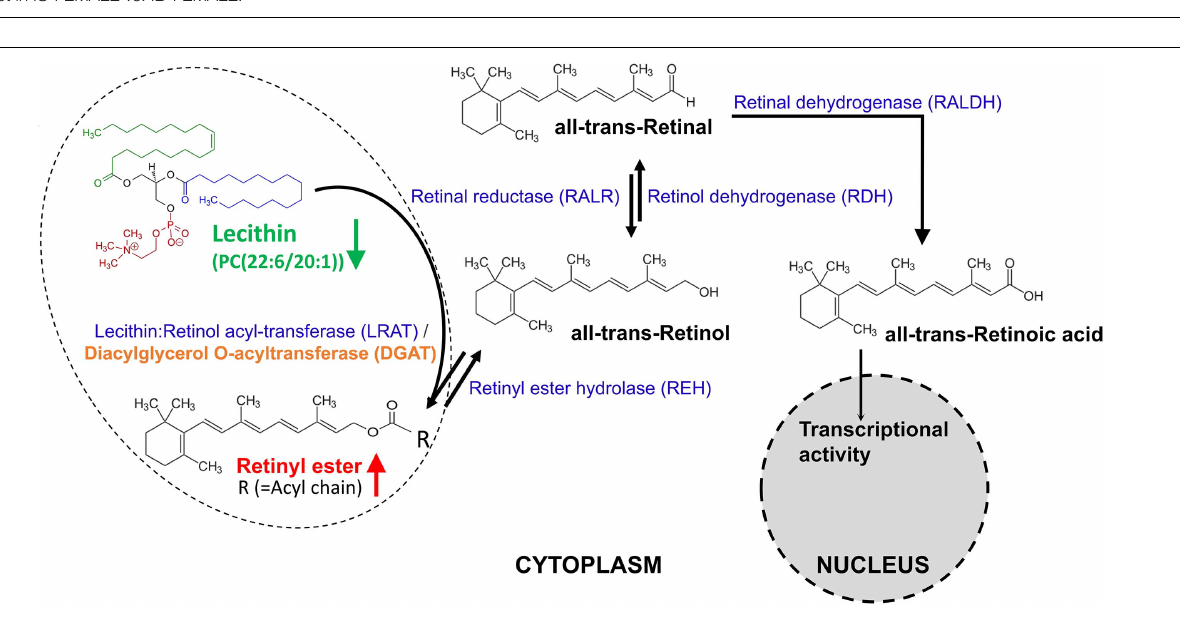
FIGURE 5 | Enrichment analysis of the differential metabolites across comparison groups. (A) : Top 8 enriched metabolite terms of the differentially expressed metabolites of IS-MALE vs. IB-MALE. The bars on x -axis represent the number of metabolites for the chemical classes mentioned on the y -axis. (B) : Enriched metabolite sets of the differentially expressed metabolites of IS-MALE vs. IB-MALE. (C) : Top 11 enriched metabolite terms of the differentially expressed metabolites of IS-FEMALE vs. IB-FEMALE. (D) : Enriched metabolite sets of the differentially expressed metabolites of IS-FEMALE vs. IB-FEMALE. (E) : Enriched metabolite terms of the common differentially expressed metabolites between IS-MALE vs. IB-MALE and IS-FEMALE vs. IB-FEMALE. (F) : Enriched metabolite sets of the differentially expressed metabolites between IS-MALE vs. IB-MALE and IS-FEMALE vs. IB-FEMALE. (G) : Enriched metabolite terms of the differentially expressed metabolites distinct in IS-MALE vs. IB-MALE. (H) : Enriched metabolite sets of the differentially expressed metabolites distinct in IS-MALE vs. IB-MALE. (I) : Enriched metabolite terms of the differentially expressed metabolites distinct in IS-FEMALE vs. IB-FEMALE. (J) : Enriched metabolite sets of the differentially expressed metabolites distinct in IS-FEMALE vs. IB-FEMALE.